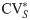
Impact of HBMi parameter values on the response patterns.Examples of simulated response patterns are shown for different values of the three quantities CVS*, 2bSνB*/b˜SνS* and b˜U. The quantities for panels A-H were CVS*={0.2,0.2,0.2,0.2,1,1,1,1}, 2bSνB*/b˜SνS*={4,4,0.4,0.4,4,4,0.4,0.4}, b˜U={0,3,0,3,0,3,0,3}.